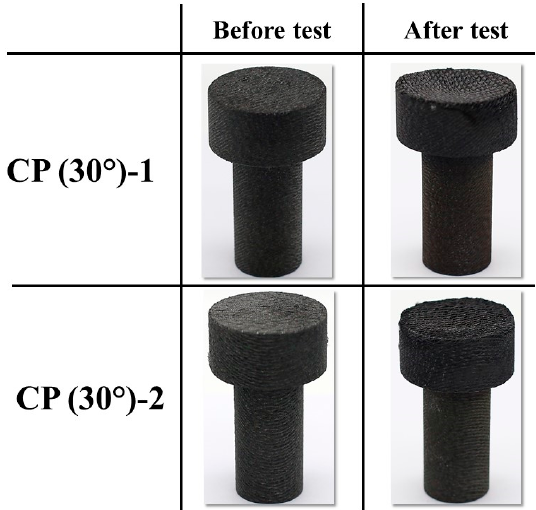
Figure 13. CP (30°)-1 (3.25 MW/m 2 , 60 s) and CP (30°)-2 (6 MW/m 2 , 30 s) before and after test images.